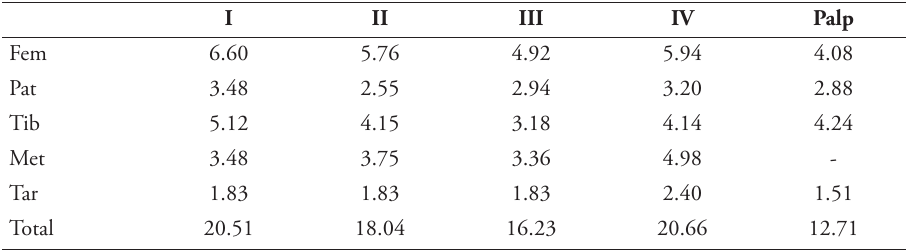
Table 1. Legs and palp measurements (in mm) of holotype CUMZ-C2-NA1 ♂ Phlogiellus longipalpus sp. n. Relation Factor (RF) = 99.27.